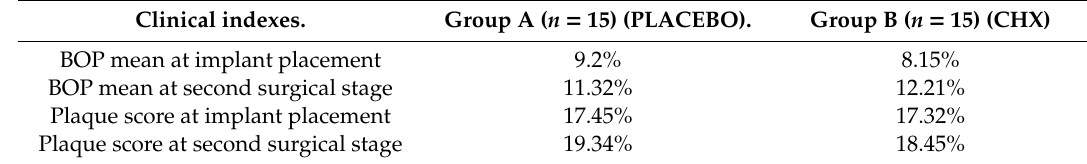
Table 2. Bleeding on probing (BOP) and plaque score at implant placement and at second surgical stage. Clinical indexes. Group A ( n = 15) (PLACEBO). Group B ( n = 15) (CHX) BOP mean at implant placement 9.2% 8.15% BOP mean at second surgical stage 11.32% 12.21% Plaque score at implant placement 17.45% 17.32% Plaque score at second surgical stage 19.34%